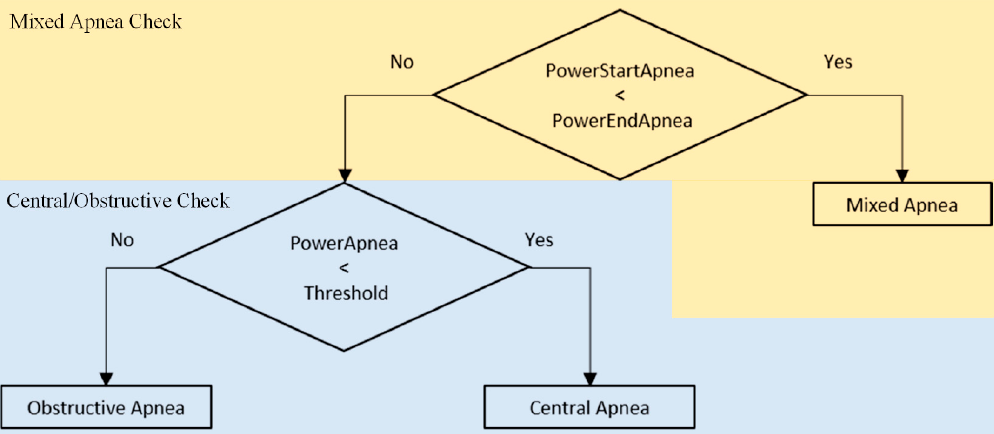
/ Central (bottom) checks.